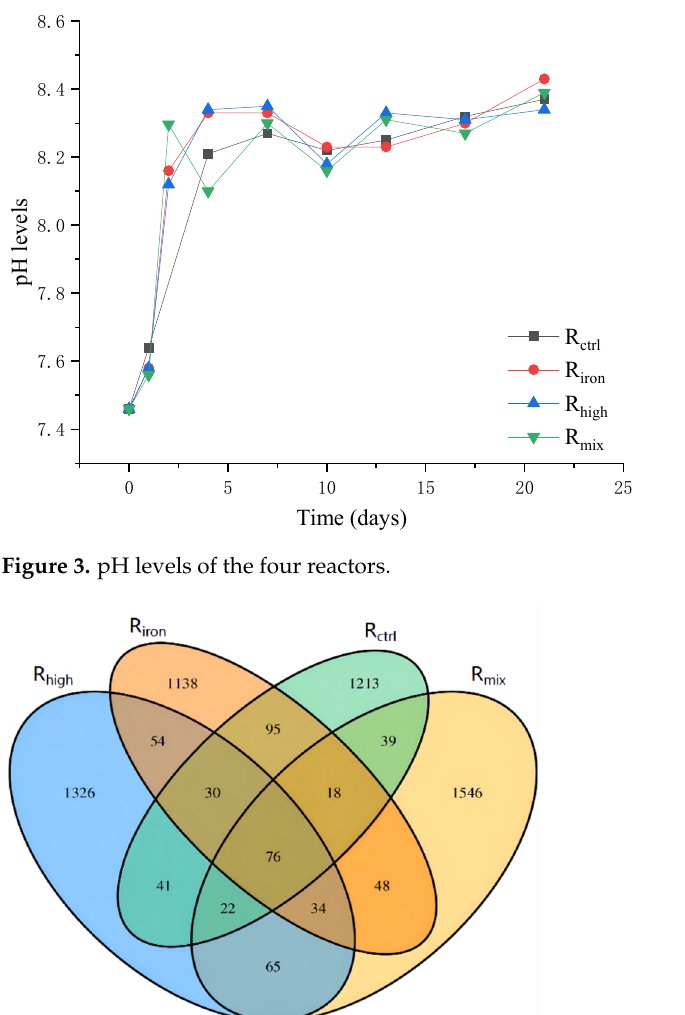
Figure 4. Venn diagram of the OTUs in the four samples. The numbers inside the diagram indicate the number of OTUs.